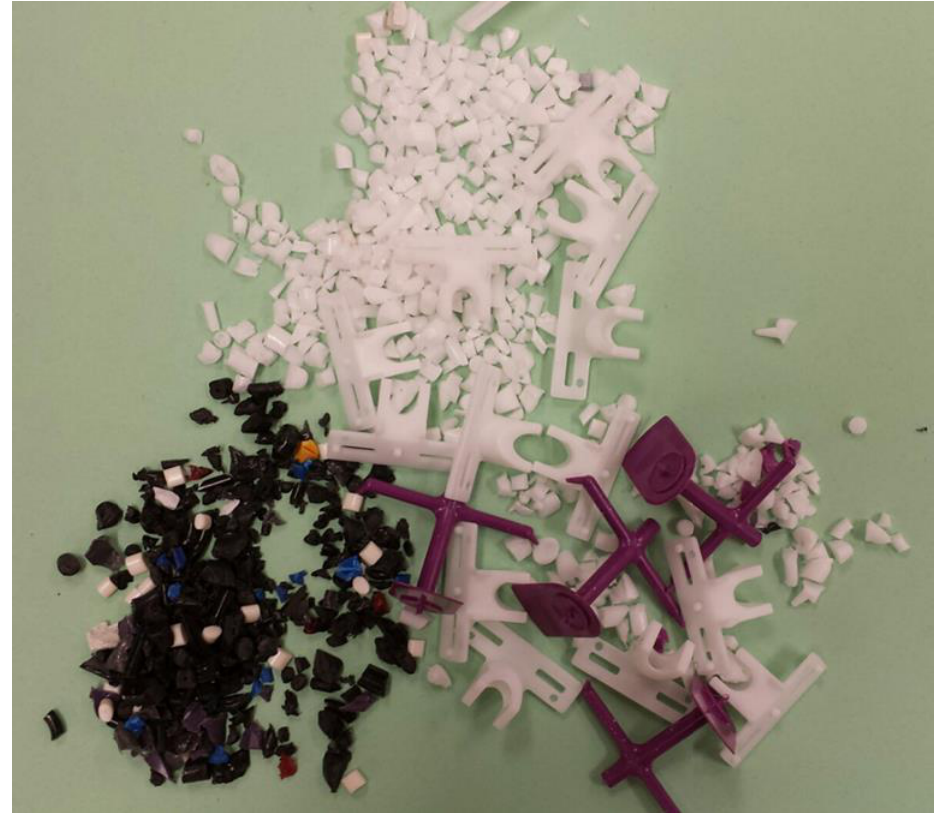
Figure 1. Typical selection of chopped/ground/shredded e-plastic resin.